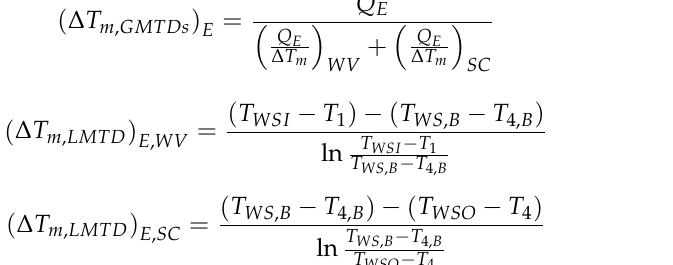
where T WS,B is the warm seawater temperature at T 4 ,B . Subscript GMTDs means the GMTDs method, LMTD is the logarithmic mean temperature difference (LMTD) method and SC is the super-cooled liquid area of the working fluid, and WV is the wet vapor